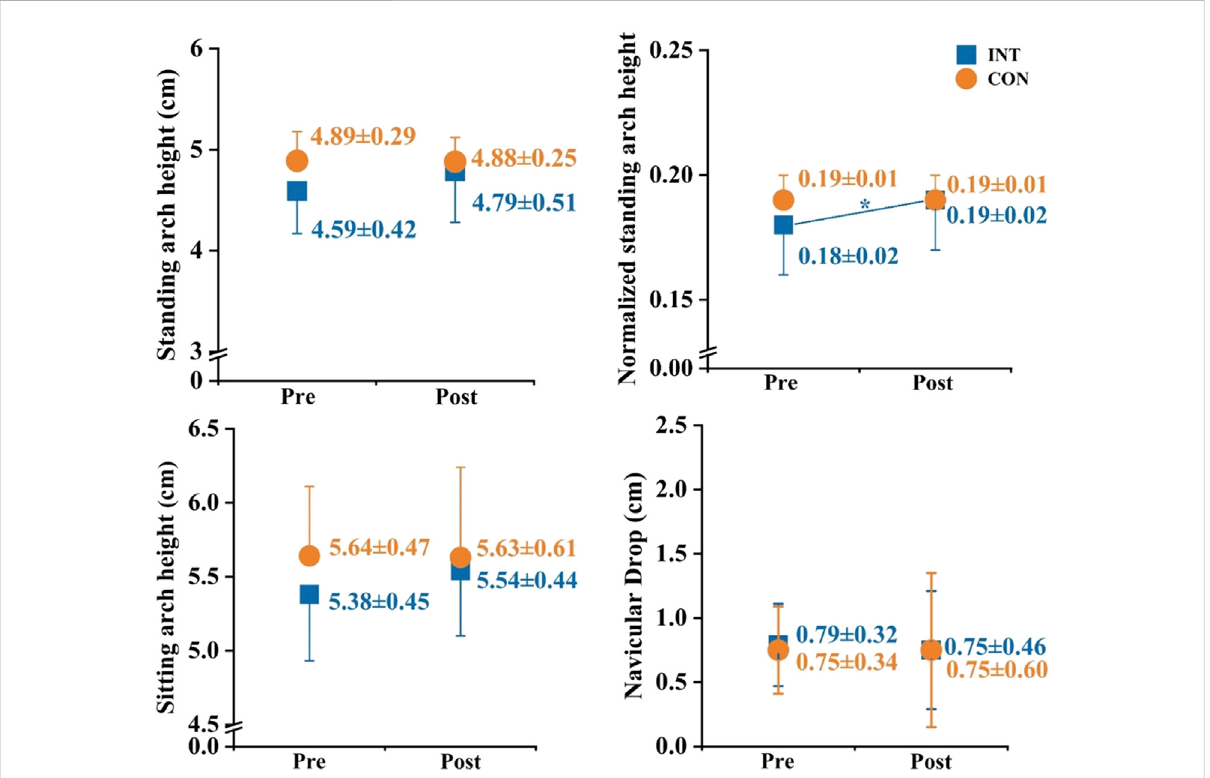
FIGURE 7 Effects of a 12-week gait retraining program combined with foot core exercise on the arch morphology. Notes: * signi fi cant difference from pre- to post-tests.